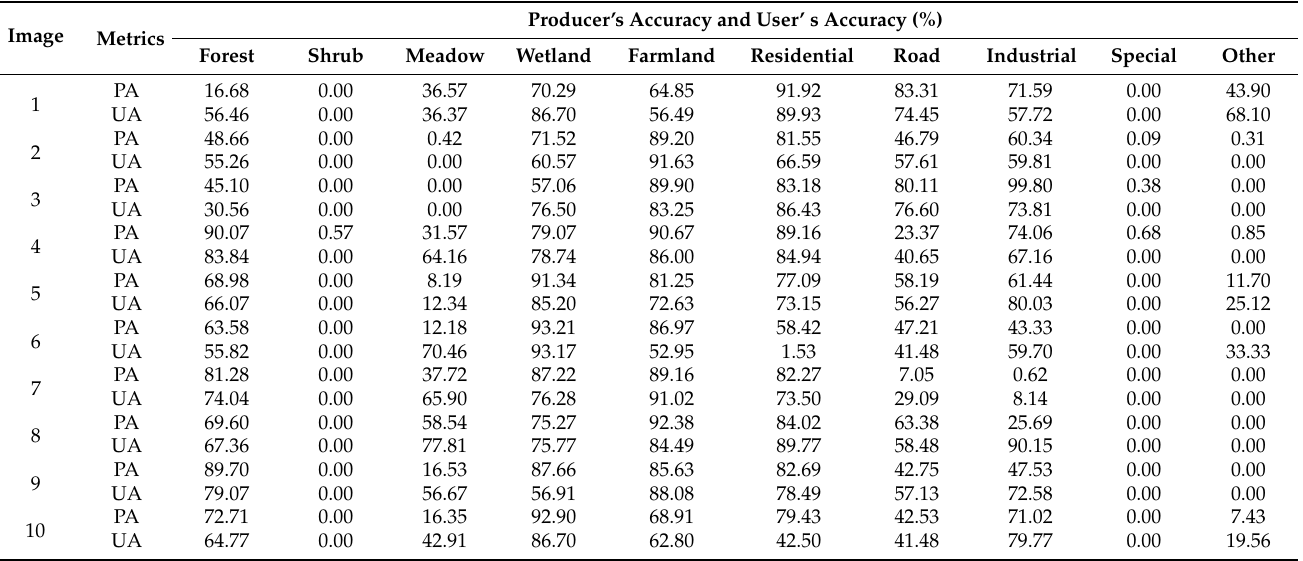
Table 4. PA and UA of Various Land Cover Types of DSLN Methods.